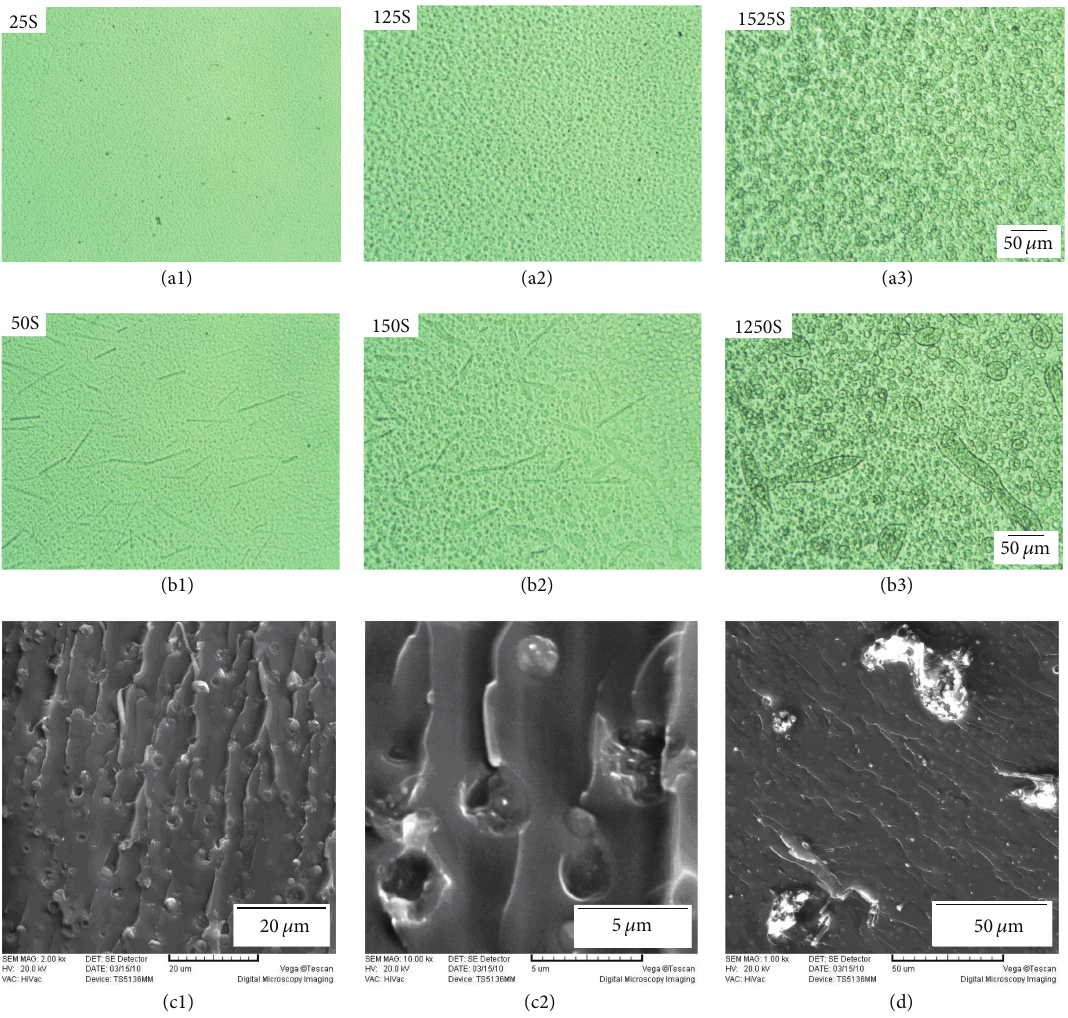
Figure 6: Development of morphologies of the PES-11.4 blend with fillers cured at 140 ∘ C followed by OM and SEM micrographs of the fracture surface of the blend with fillers cured at 140 ∘ C for 5h. (a1)–(a3) PES-11.4-A by OM; (b1)–(b3) PES-11.4-Ca by OM; (c1) and (c2) PES-11.4-A by SEM; (d) PES-11.4-Ca by